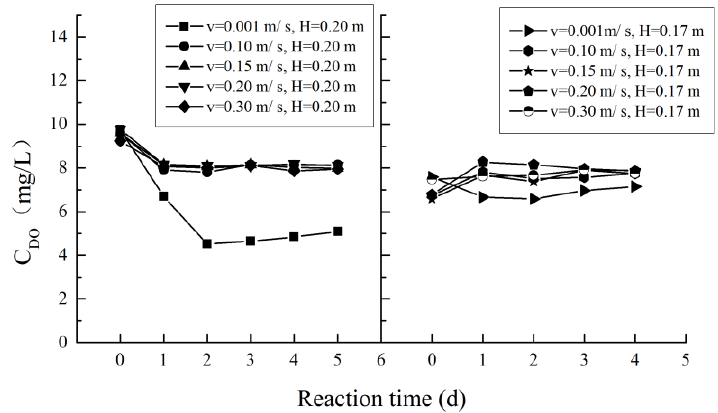
Figure 6. Variation of the dissolved oxygen (DO) concentration.